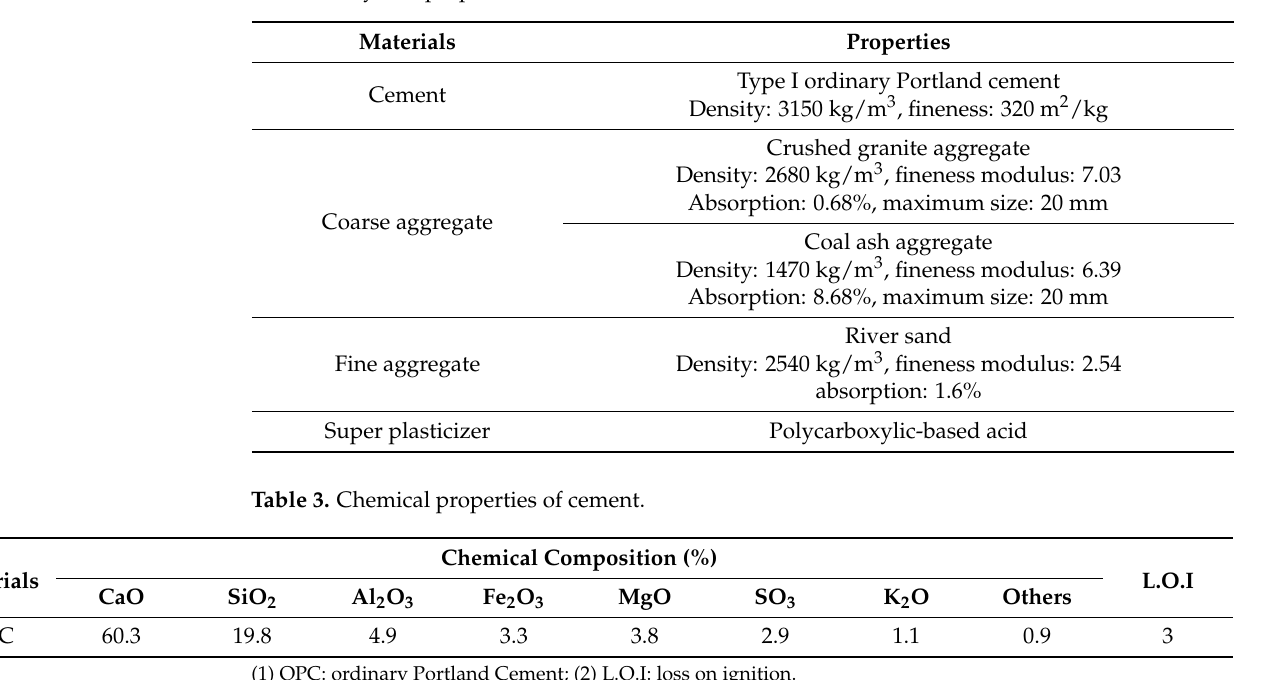
Table 2. Physical properties of the materials.